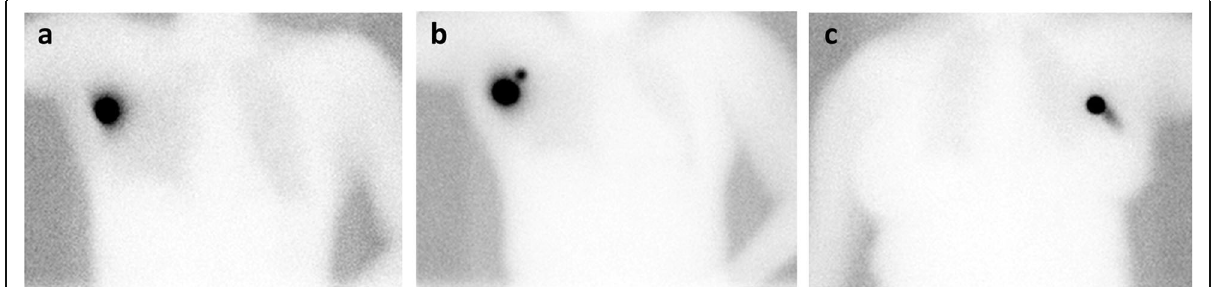
Fig. 3 Planar anterior scintigraphy images in three different patients after the ROLL-node injection in the clip-marked lymph node, displaying the three different scintigraphic patterns. a One clear focus is observed in the axilla. b Two focal hotspots are observed in the axilla, corresponding to the ROLL-marked node and drainage to one higher echelon node. c One focal hotspot is observed in the axilla with minimal radioactivity in the needle